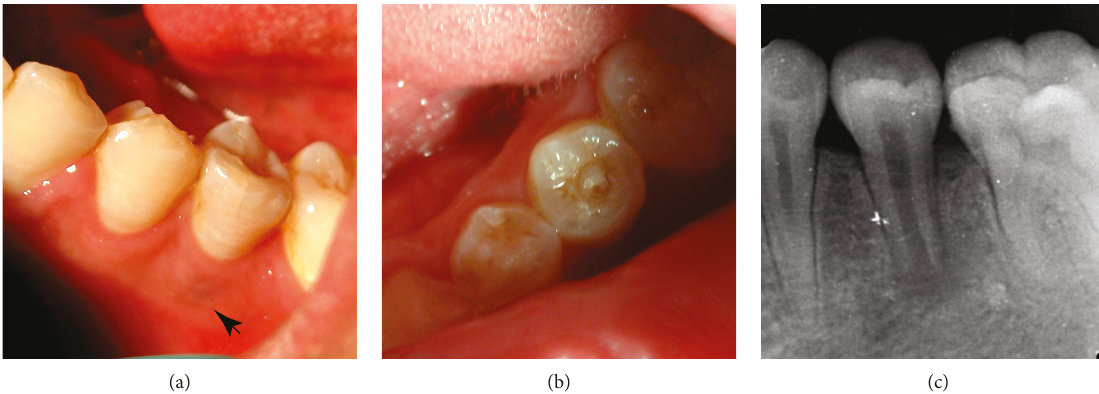
Figure 1: Clinical photograph and periapical radiograph of this case. (a) The clinical photograph shows a violet-blue patch with a diameter of 2 mm in the buccal gingiva of tooth #20. (b) The clinical photograph shows an attrited abnormal center cusp at the center of the occlusal surface of tooth #20. (c) The periapical radiograph shows a radiolucent lesion at the periapical area of tooth #20 with a wide open